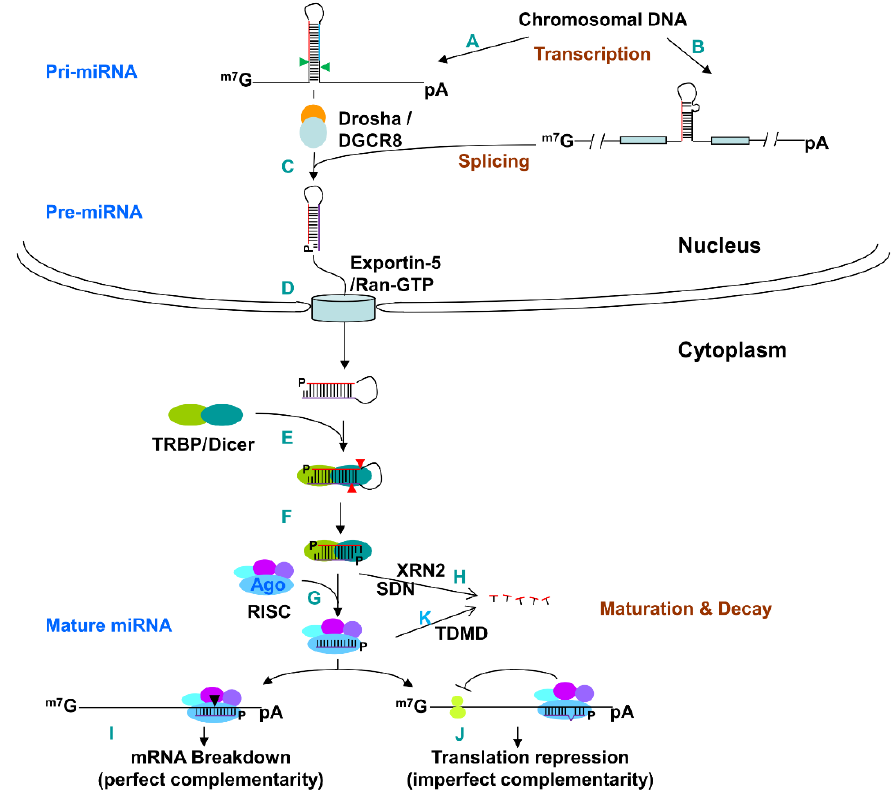
Figure 1. miRNA biogenesis and functions. In the nucleus, the primary transcript of miRNA, referred as pri-miRNA, is mostly transcribed by RNA polymerase II ( A ). More than 25% of the conserved and >50% of the poorly conserved miRNAs are derived from introns of protein-coding genes ( B ). The pri-miRNAs fold into hair-pin structures, which are cleaved by an RNase III endonuclease, Drosha in the Drosha-DGCR8 complex, to form 60–70 nt stem loop intermediates, known as pre-miRNAs, with a 2-nt 3′ overhang ( C ). Pre-miRNAs are transported to the cytoplasm by Ran-GTP and an export receptor, Exportin 5 ( D ). In the cytosol, pre-miRNAs are cleaved by another RNase III endonuclease, Dicer in the Dicer/TRBP complex, to form ~22-bp miRNA duplexes with a 2-nt 3′ overhang ( E,F ). TRBP recruits Agonaute protein Ago2 and other Ago proteins to initiate the assembly of the RNA-induced silencing complex (RISC). One strand of the duplex becomes mature miRNA and is incorporated in the RISC complex ( G ); the other strand, miRNA*, is degraded by small RNA degrading nuclease (SDN) (in Arabidopsis ) and 5′ - 3′ exonuclease 2 homolog (XRN2) in Caenorhabditis elegans ( H ). Mature miRNAs base pair with their target mRNAs in the 3′ UTR ( I,J ). When the miRNA and the target sites have perfect or nearly perfect complementarity, miRNAs direct cleavage of the target mRNAs by Ago2 ( I ); when the base-pairing is imperfect, miRNA with the RISC can destabilize the mRNA by deadenylation and subsequent decapping, and repress translation of the targeted mRNA by blocking translation initiation and/or inhibiting elongation ( J ). (Modified from Xu, 2009 [6]). Muture miRNA can be also degraded through target RNA-directed miRNA degradation (TDMD) ( K ).